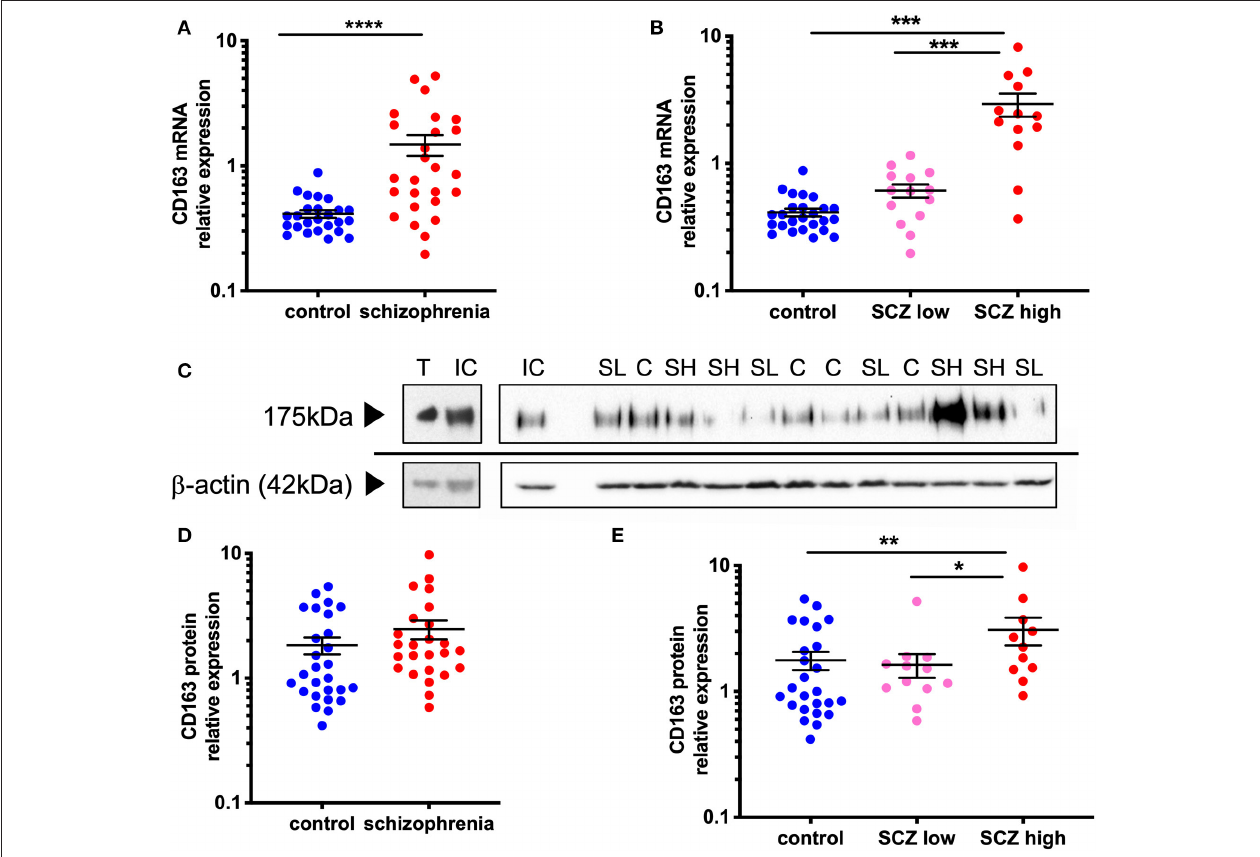
FIGURE 2 | CD163 mRNA and protein is increased in the midbrain in schizophrenia cases classified with a high inflammatory biotype. (A) CD163 mRNA was significantly increased in the midbrain of schizophrenia cases compared to control cases ( F = 25.31 df = 49,1, p < 0.001). (B) CD163 mRNA was significantly increased in the high inflammatory/schizophrenia subgroup compared to both the low inflammatory/schizophrenia subgroup and the controls ( F = 35.18, df = 50,2, p < 0.001). (C) CD163 band at 175 kDa was detected in all samples including in mouse thymus positive control. β -actin ( ∼ 42 kDa) was detected in all samples and used as a normalizing control. (D) CD163 protein expression was not significantly different in schizophrenia cases compared to controls ( t = − 1.63, df = 50, p = 0.11) but, when analyzed by (E) inflammatory subgroup ( F = 4.65, df = 46,2, p = 0.014), CD163 protein was significantly increased in the high inflammatory/schizophrenia subgroup compared to both the low inflammatory/schizophrenia subgroup and the controls. Data are mean ± SEM, * p < 0.05, ** p < 0.01, *** p < 0.001, **** p < 0.0001. C, control; SL, low inflammatory/schizophrenia; SH, high inflammatory/schizophrenia; IC internal control; T,